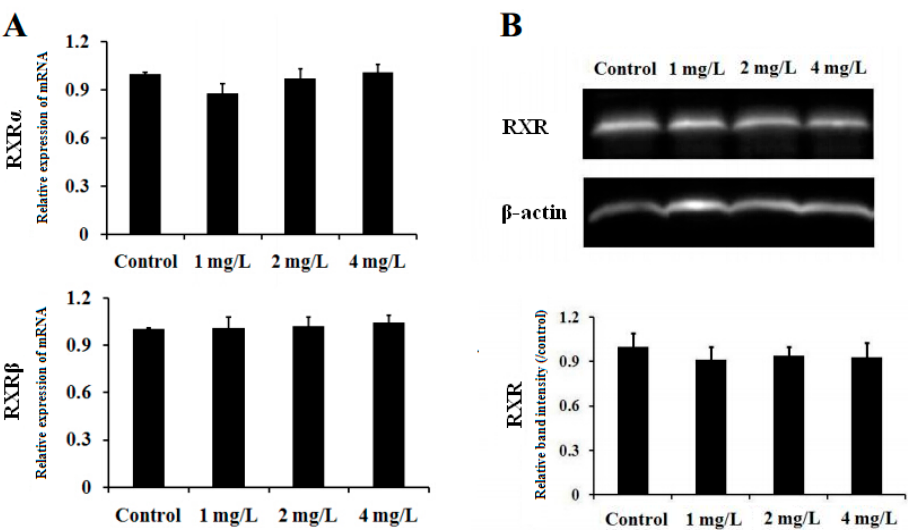
Figure 7. Effect of As exposure on gene ( A ) and protein ( B ) expression of RXR in cerebellar tissue of mice. Adult male mice exposed to 0, 1, 2, and 4 mg/L As 2 O 3 in drinking water for 60 days. After the treatment, the expression of RXR gene and protein was analyzed by real time RT-PCR and western blot, respectively. The relative abundance of RXR mRNA and protein was determined by the ratio of sample to β -actin. Data obtained from six separate analyses are expressed as mean ± SD ( n = 6 for each group).